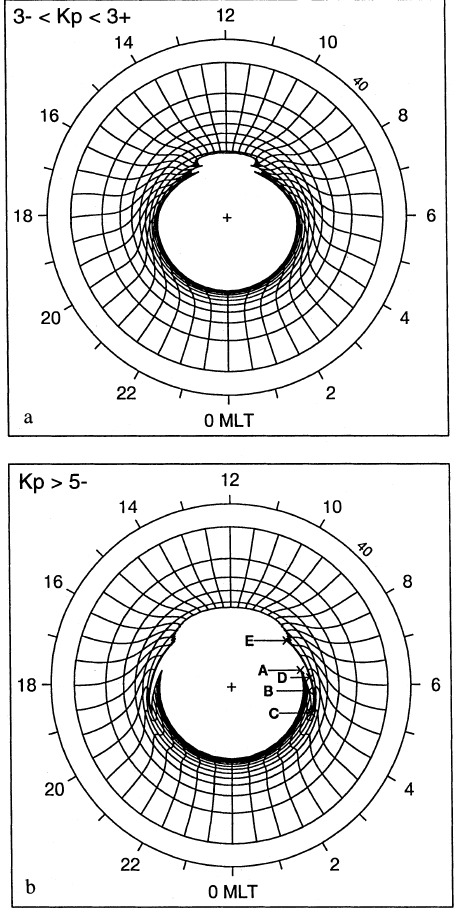
Fig. 5a, b. Ionospheric map of the Euler potentials between the North Poleand40 (cid:14) invariantlatitudewiththeMagneticLocalTimeindicated on the external circle a for 3 (cid:255) < Kp < 3 (cid:135) and b for 5 (cid:255) < Kp . The contour format is similar to Fig. 3a, b. The points A ; B ; C ; D and E are mapped down to the equatorial plane of the magnetosphere and their equatorial conjugates are indicated in